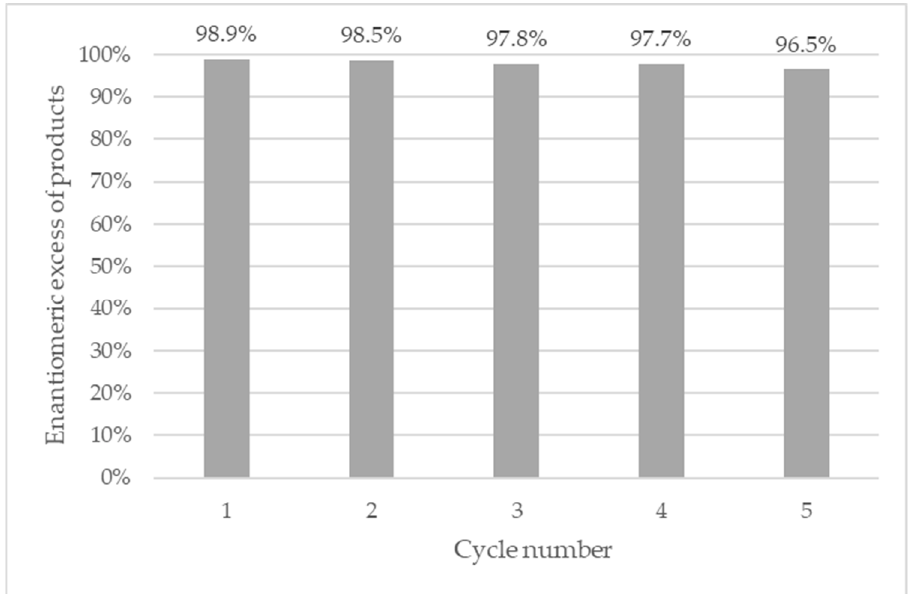
Figure 8. Comparison of the values of enantiomeric excesses of products in five reaction cycles with the reused lipases from Burkholderia cepacia in enantioselective biotranformation of ( R , S )-1-phenylethanol.